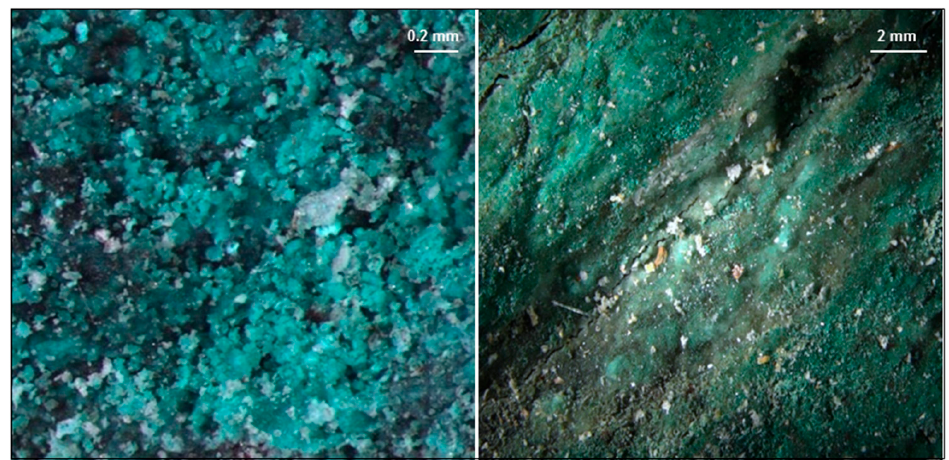
Figure 7. Di ff erent aspects of dark green atacamite (stereomicroscope Figure 7. Different aspects of dark green atacamite (stereomicroscope images).